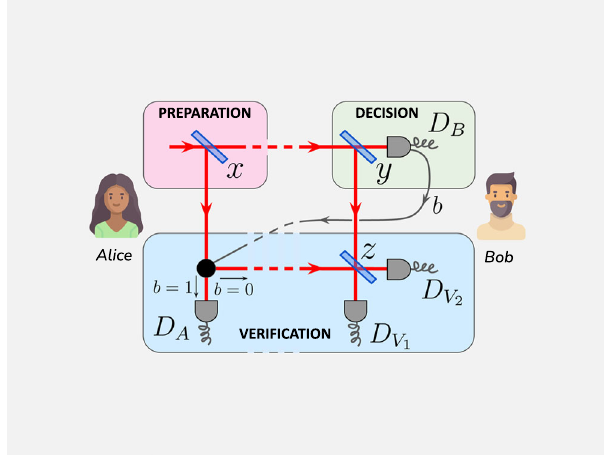
Fig. 1 | Schematic description of cheat-sensitive quantum weak coin fl